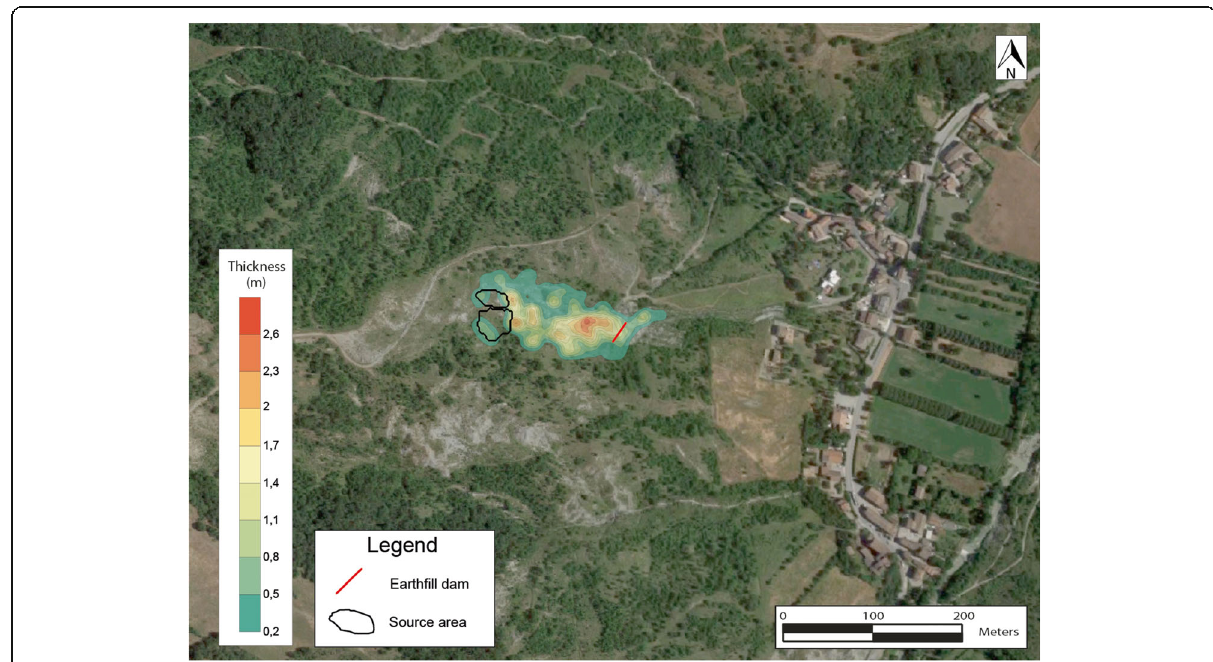
Fig. 15 Deposit flow thickness from the DAN3D